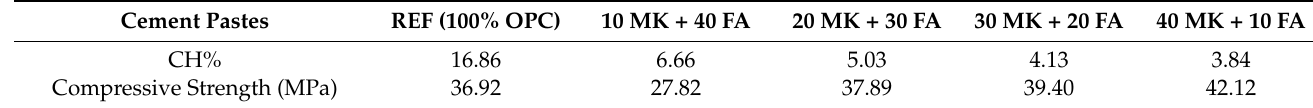
Table 4. Percentage of CH and 28d-compressive strength of cement